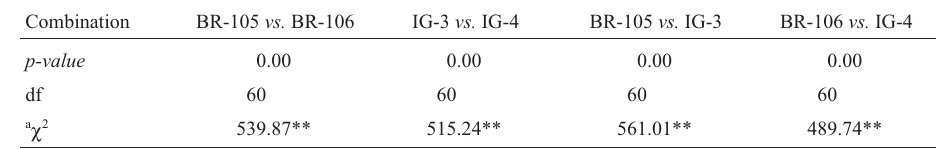
Table 2 - Differences in the allele frequency distribution in the four combinations between maize materials. Combination BR-105 vs. BR-106